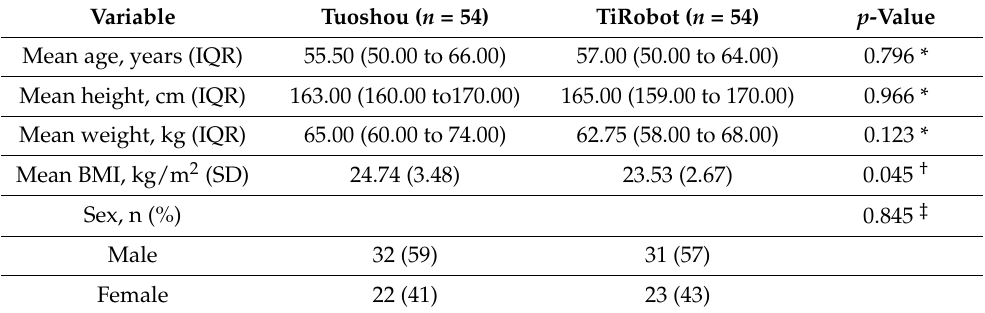
Table 1. Baseline Characteristics.